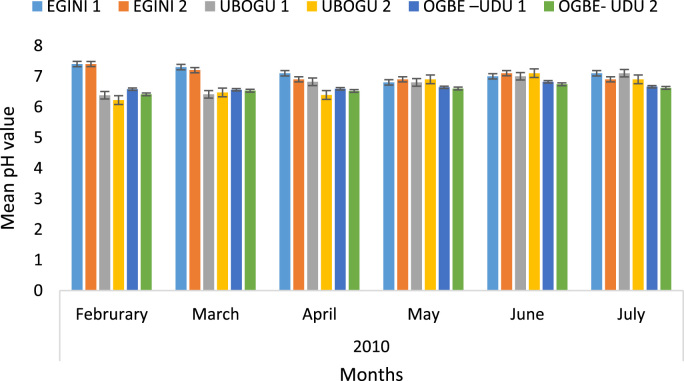
Mean Temporal and spatial variations in PH value.